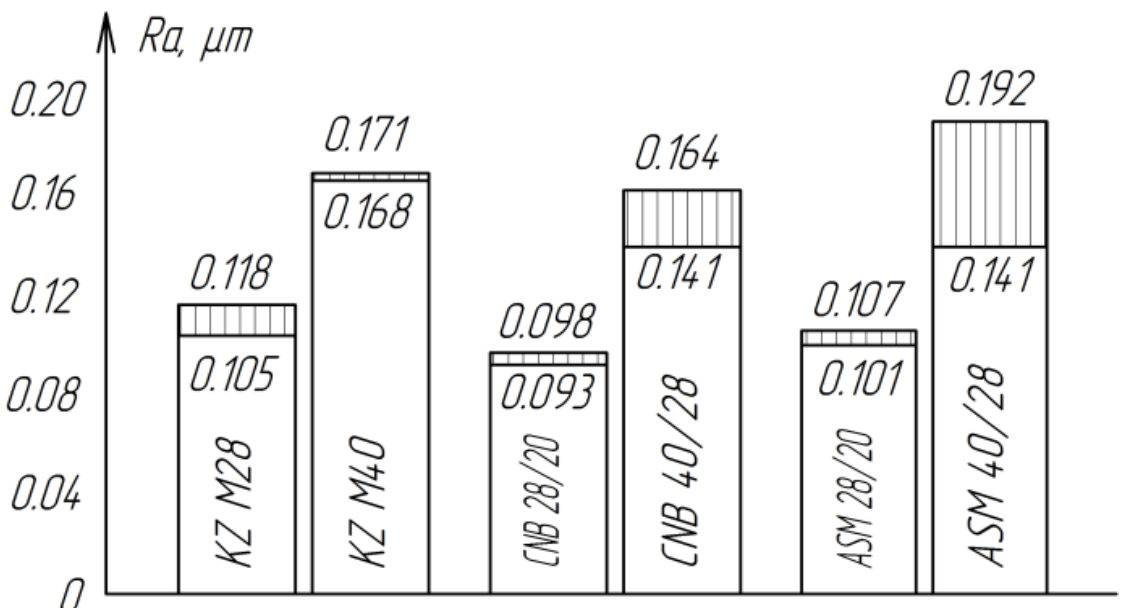
Figure 7. Influence of the type and grain size of the abrasive material on the roughness of the treated surface of ZrO 2 ceramics.